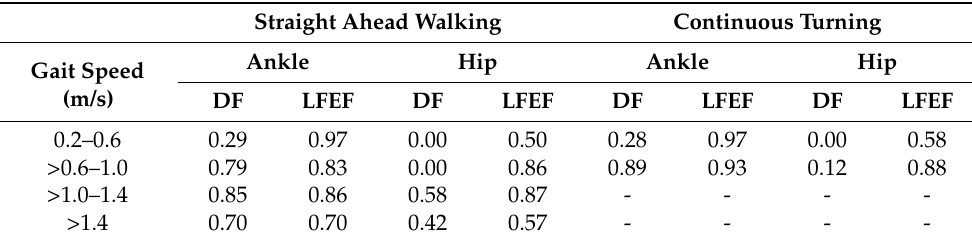
Table 2. ICC 2,1 between SW activity monitor and the ankle and hip worn AG using the DF and the LFEF for different gait speeds during straight walking and walking with continuous